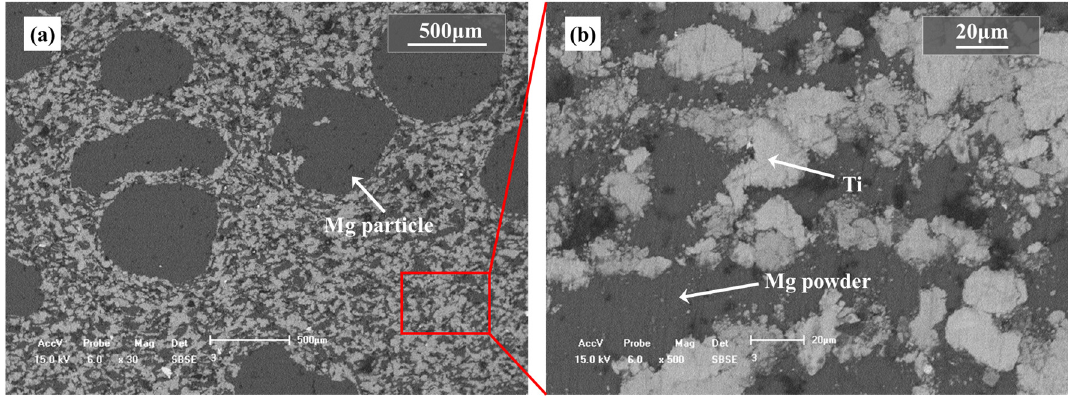
Figure 3. SEM images of prefabricated compact, ( a ) inner morphology on the cross section along pressing direction, ( b ) local amplification of ( a ).